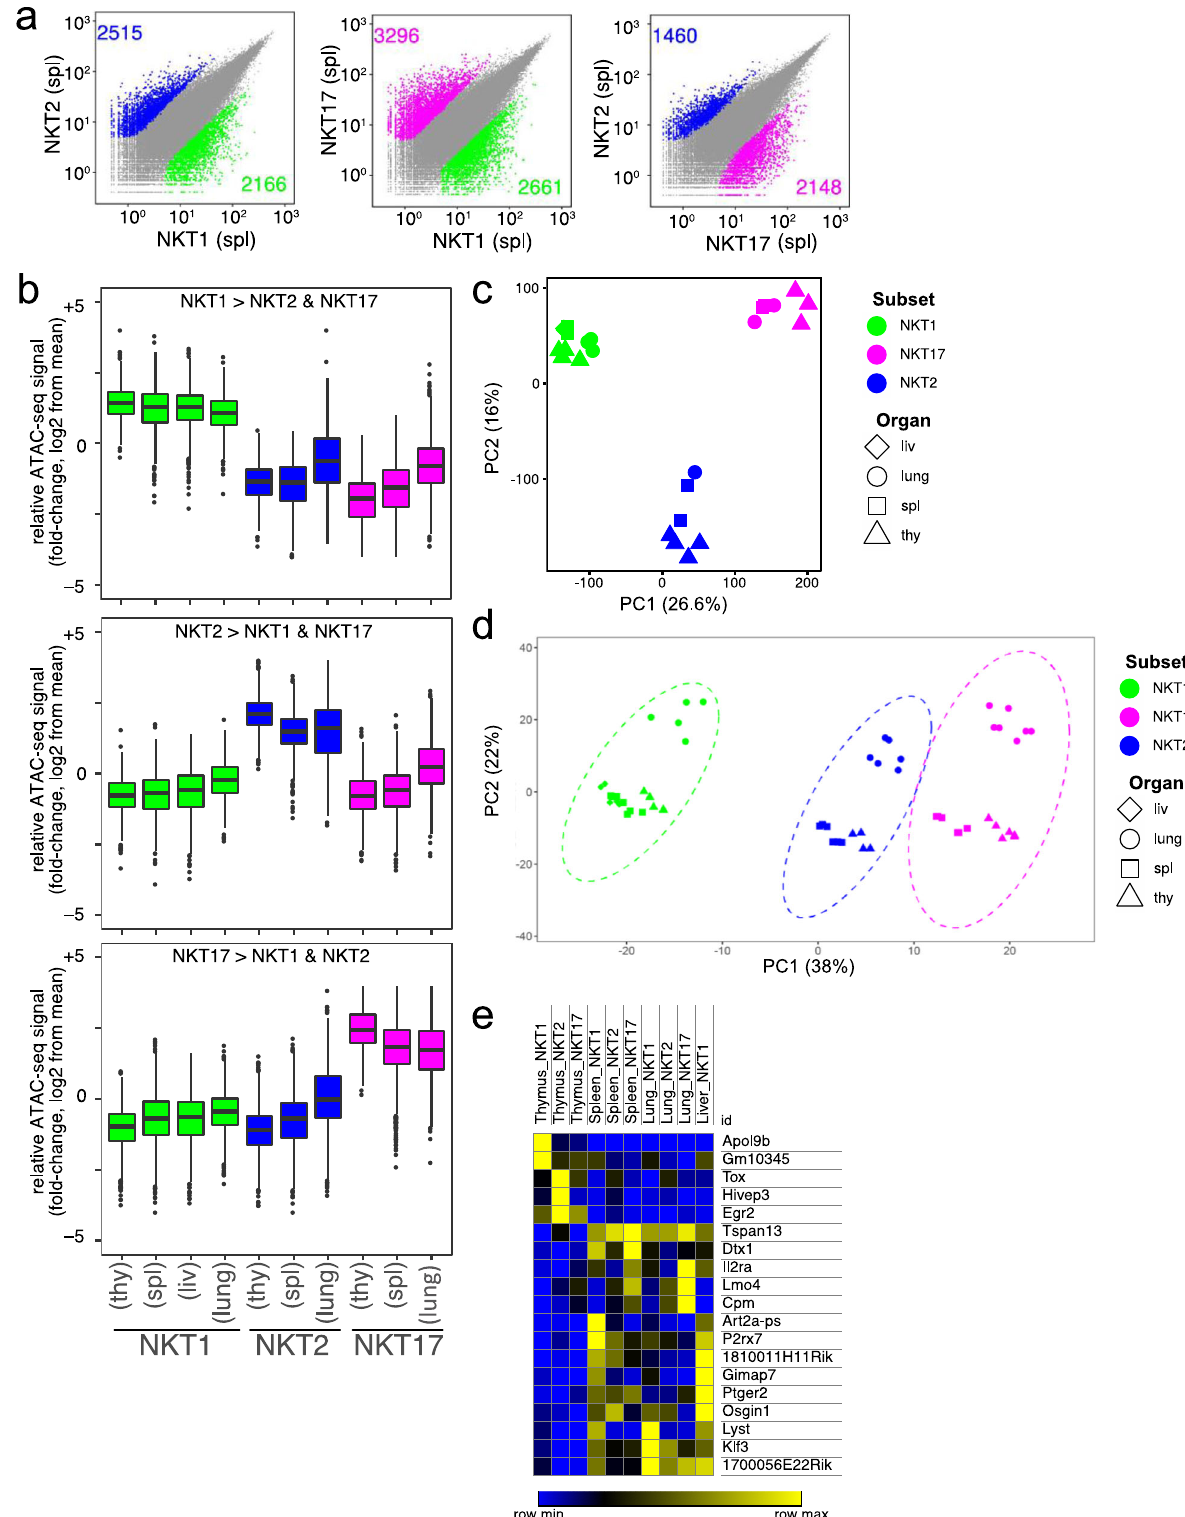
Fig. 2 Imprint of tissue location is minor compared to the subset. a Scatterplot of mean ATAC-seq counts per peak comparing differentially accessible regions of chromatin for pairs of iNKT cell subsets in the spleen (spl.). Colors indicate differentially accessible regions de fi ned by limma/voom (details in ‘ Methods ’ ). b Boxplot of normalized average ATAC-seq counts per peak from the indicated samples (labeled at bottom) at differentially-accessible regions that distinguish thymic iNKT cell subsets. Box indicates interquartile range with whiskers + / − 1.5 times this range and outlier points indicated. n = 4 for thymic NKT1 and NKT2, n = 3 for thymic NKT17 and lung NKT1, n = 1 for lung NKT2, and n = 2 for all other samples. c , d PCA display of ATACseq ( c ) and RNA-seq ( d ) data from the indicated iNKT cell subsets from the different tissues. e Heat map of normalized reads from RNA-seq for genes (19) differentially regulated in thymus versus peripheral iNKT cell subsets, within all subsets, n > 2-fold difference, p =